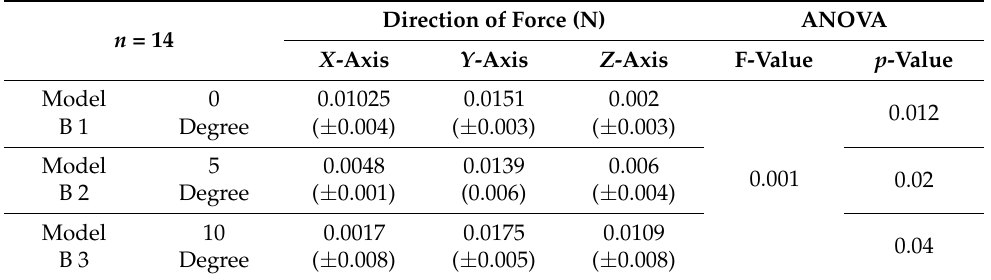
Table 4. Direction of force in all